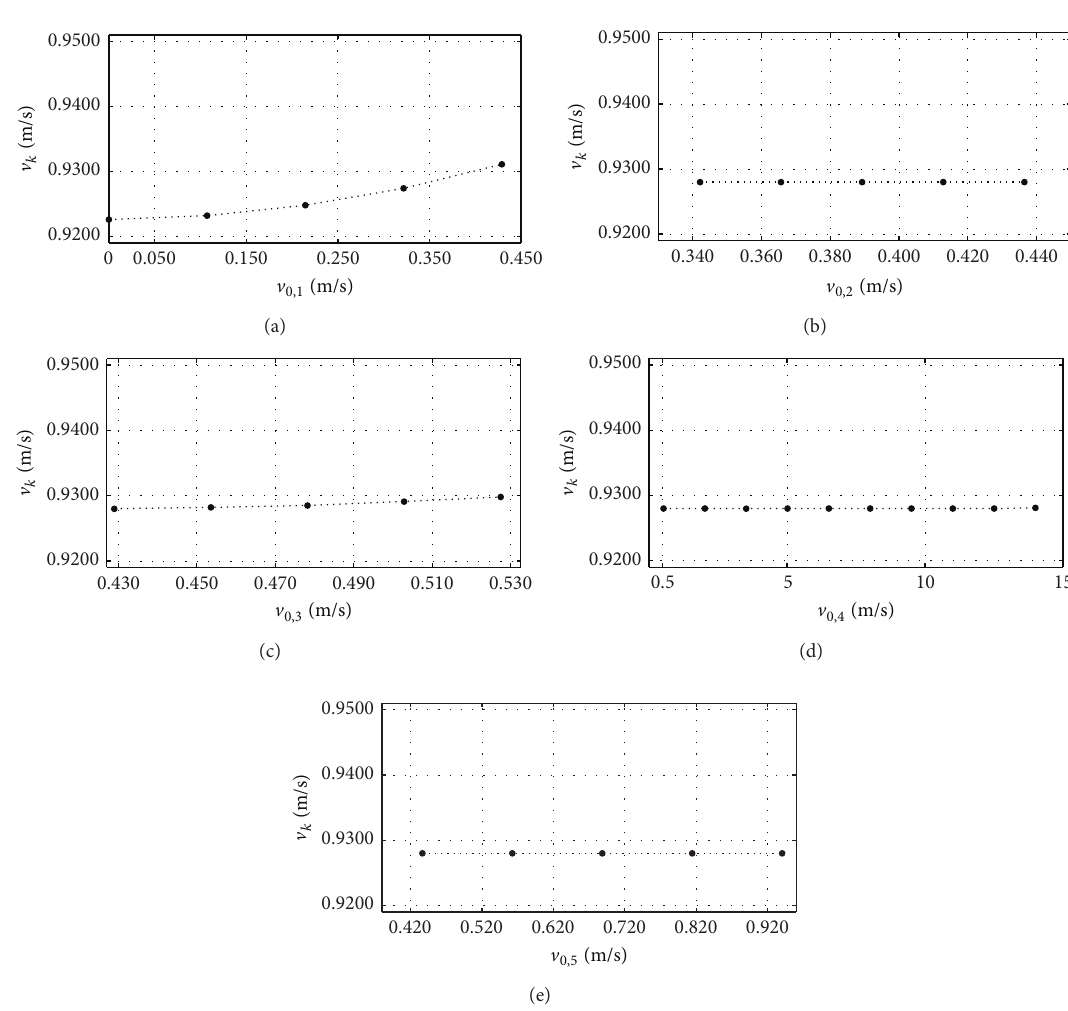
The flow velocity is described by equation of motion of falling body in inclined plane due to gravitational